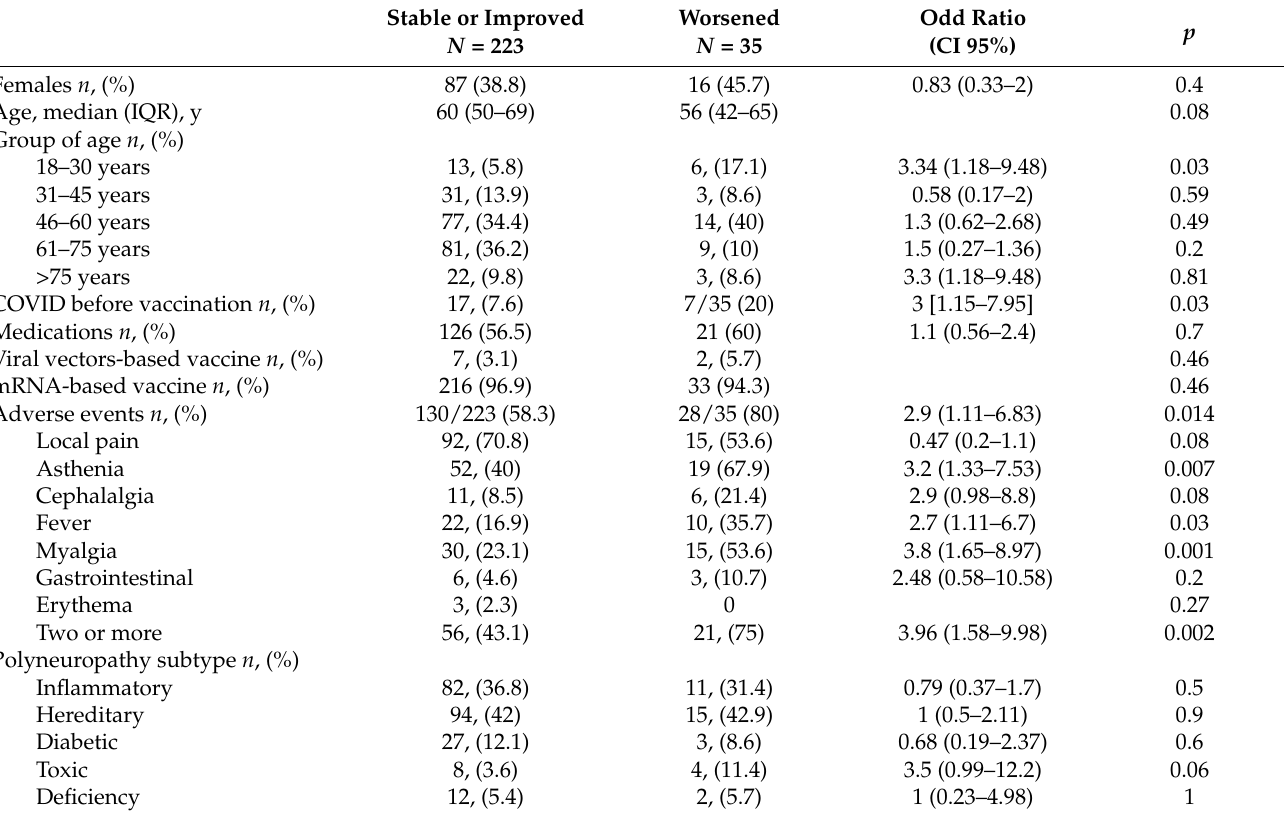
Table 3. Comparison between demographic and vaccination features between stable or improved and worsened